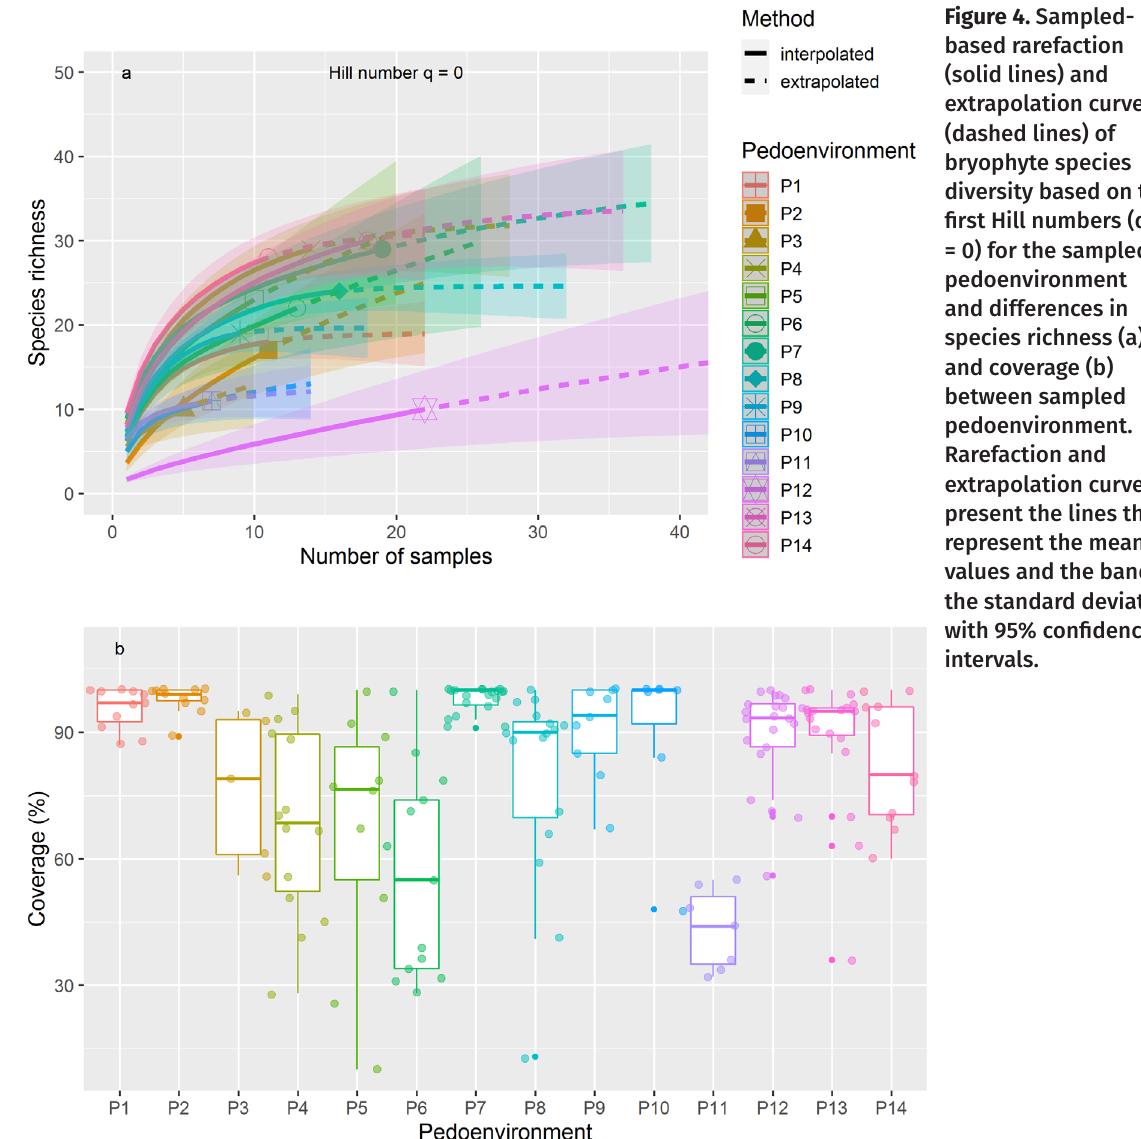
Figure 4. Sampled- based rarefaction (solid lines) and extrapolation curves (dashed lines) of bryophyte species diversity based on the first Hill numbers (q = 0) for the sampled pedoenvironment and differences in species richness (a), and coverage (b) between sampled pedoenvironment. Rarefaction and extrapolation curves present the lines that represent the mean values and the bands the standard deviation with 95% confidence